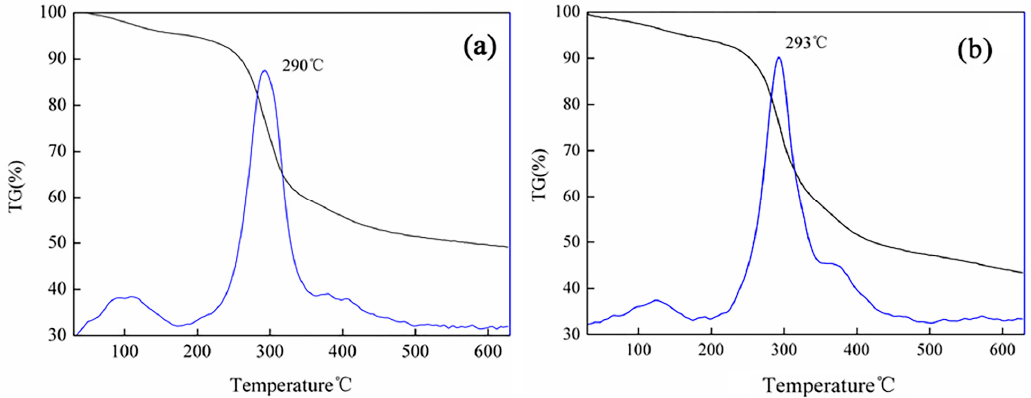
Figure 2. TG/DTG spectra of ( a ) OCMCS-Pd and ( b ) OCMCS-Ni.